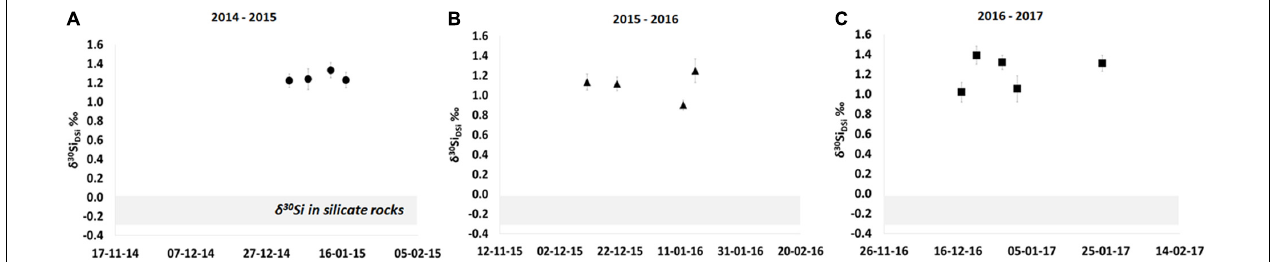
FIGURE 5 | Dissolved silicon isotope composition ( δ 30 Si DSi ) in < 0.4 µ m filtered water from Crescent Stream. Samples were collected between December and February 2014–2015 (A) ; 2015–2016 (B) ; 2016–2017 (C) . The gray band shows the range of δ 30 Si in silicate rocks (Georg et al., 2007b; Savage et al., 2010, 2011; Armytage et al., 2011). The error bars correspond to the standard deviation for silicon isotope measurements